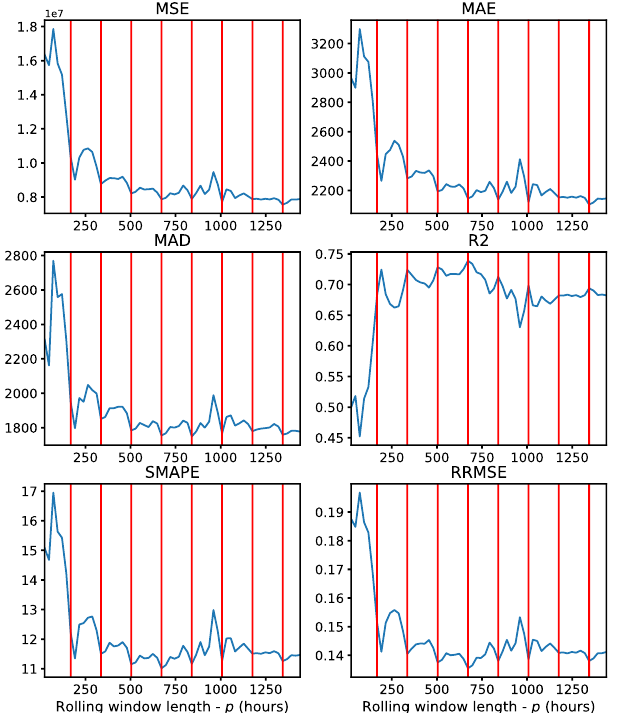
Figure 11. Influence of the rolling window length ( p ) on different forecast metrics (MSE, MAE, MAD, R 2 , SMAPE and RRMSE), obtained with the DMD model. The range of values for p is between 24 (1 day) and 1440 h (60 days).